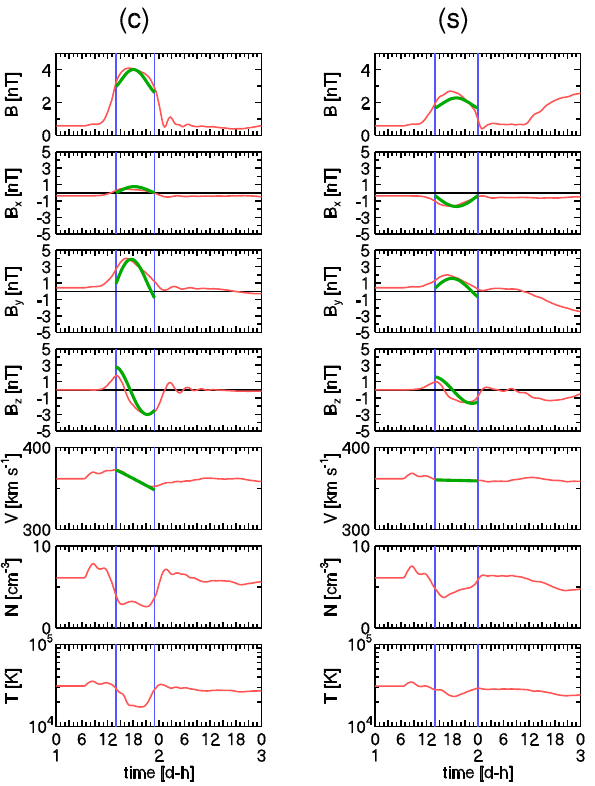
Fig. 7. Simulated time profiles near (c) and in the point A (s) for a flux rope inclined 20 ◦ to the ecliptic plane. The layout is similar to Fig. 2.